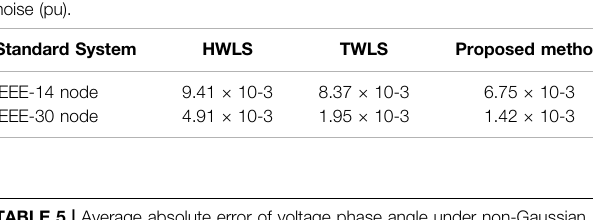
TABLE1| AverageabsoluteerrorofvoltageamplitudeunderGaussiannoise(pu).